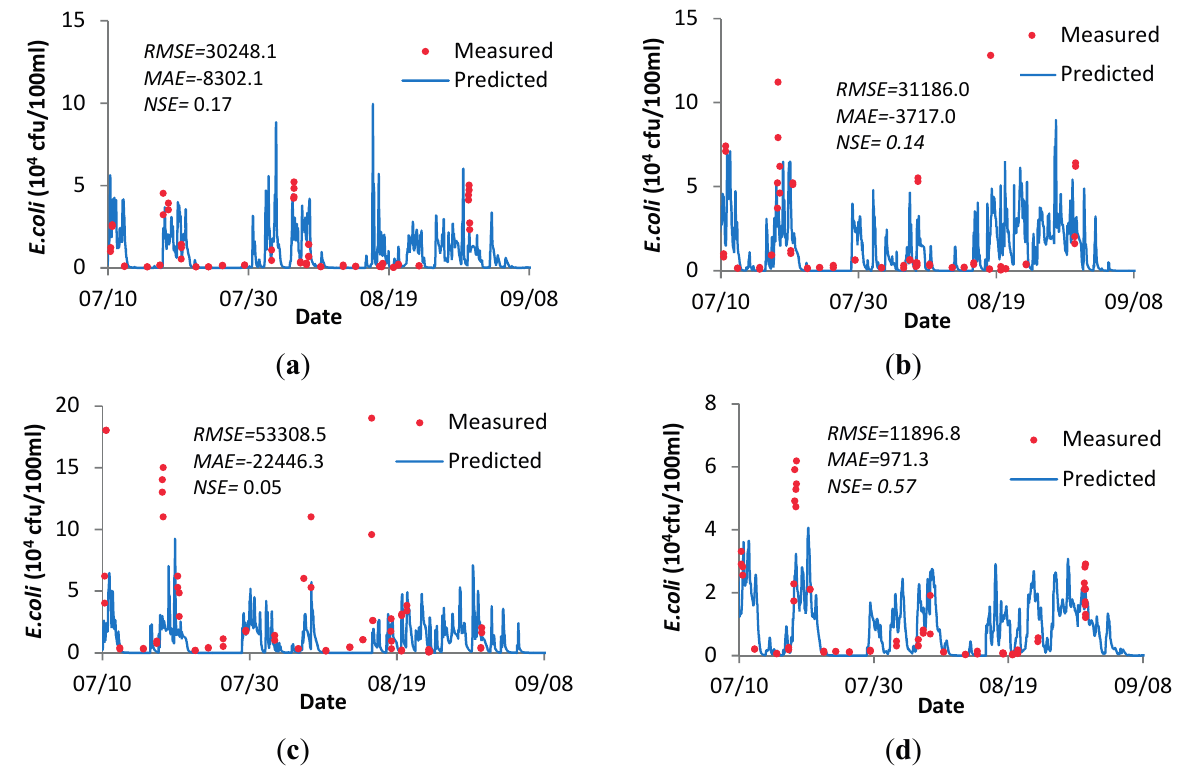
Figure 4. Escherichia coli verification (colony forming units) verification at 4